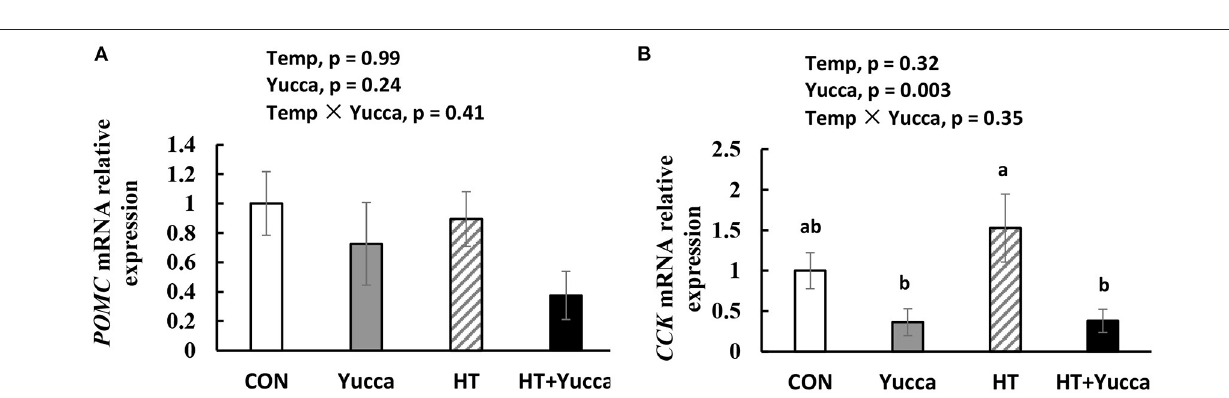
FIGURE 4 | Hypothalamic mRNA expression of POMC (A) and CCK (B) in broilers at 56 days. Broilers, of 28 days of age, were fed a basal diet and exposed to 24 ◦ C (CON) or 34 ◦ C (HT), or a basal diet supplemented with 0.1% yucca and exposed to 24 ◦ C (Yucca) or 34 ◦ C (HT + Yucca) for 4 wks. Values are means ± SE, n = 6. Means without a common letter differ ( P <